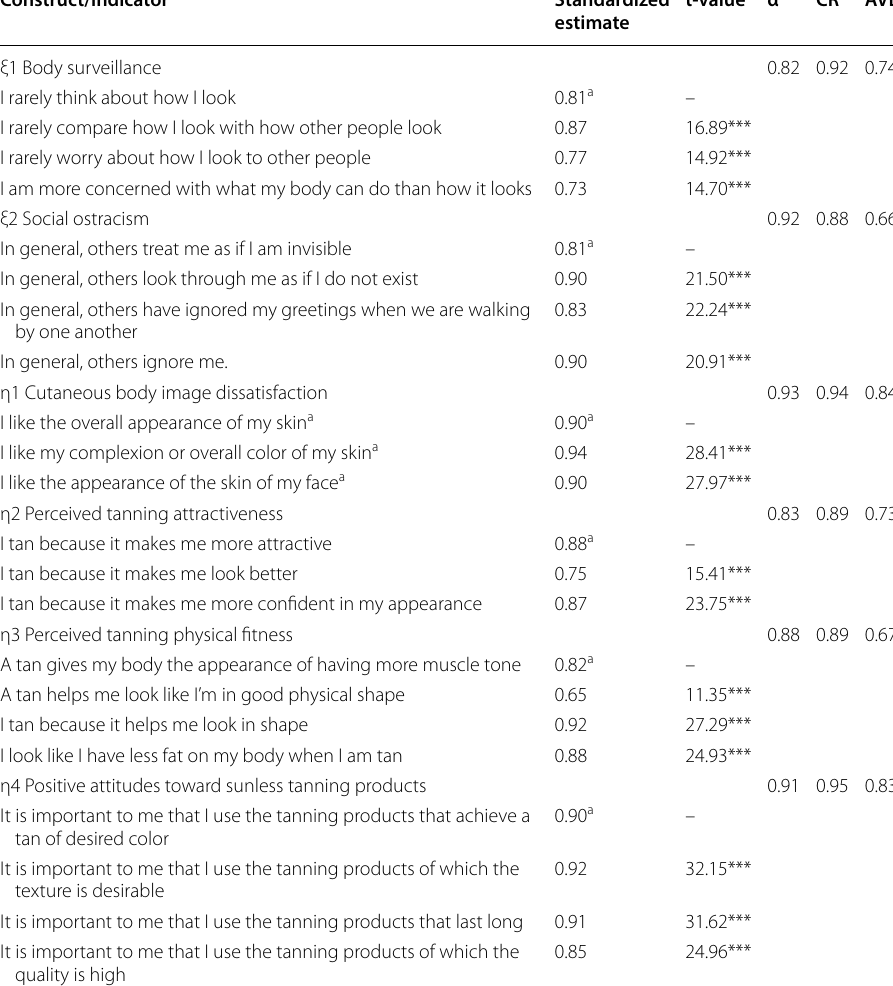
Table 1 Confirmatory factor analysis results (n